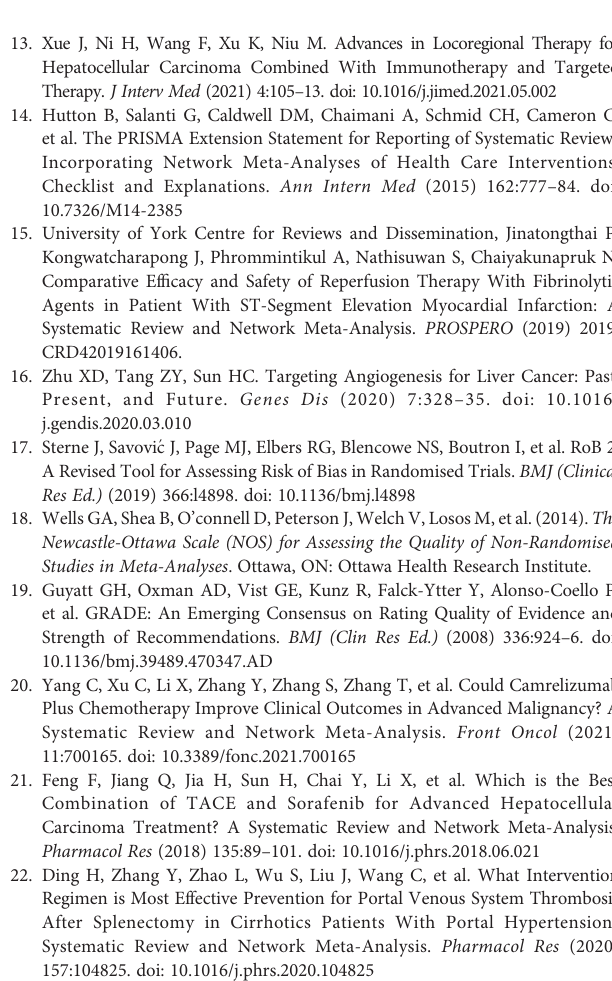
Supplementary Figure 1 | Risk of bias summary Cochrane Collaboration ’ s tool. Supplementary Figure 2 | Inconsistency plot of included studies with treatment response. Supplementary Figure 3 | Network funnel plot of included studies with treatment